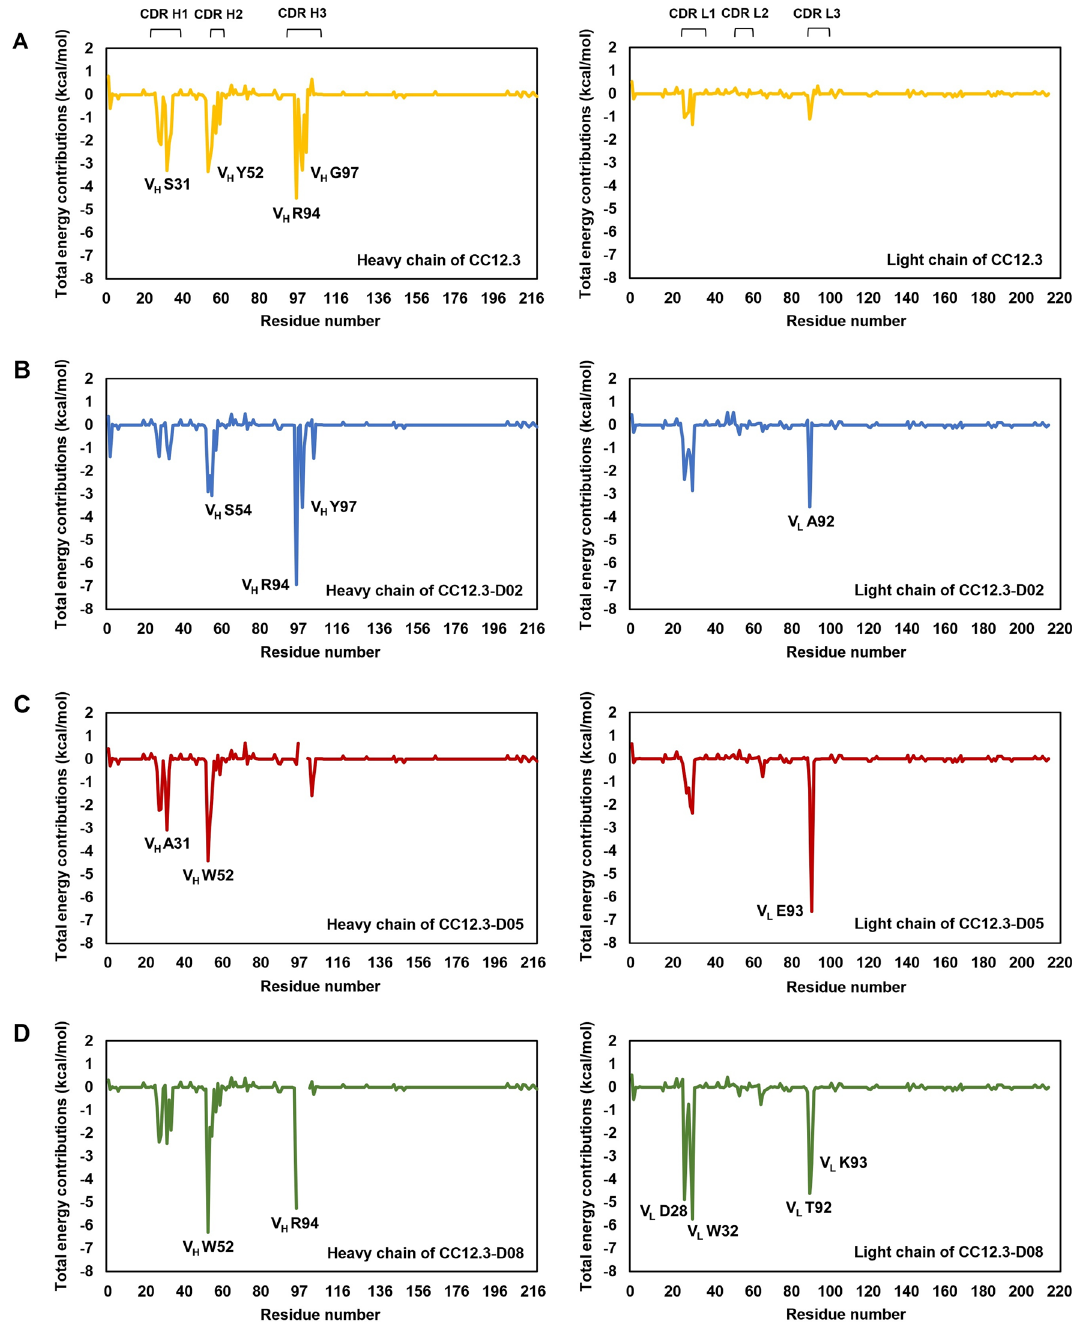
Figure 3. Per-residue free energy decomposition of ( A ) CC12.3, ( B ) CC12.3-D02, ( C ) CC12.3-D05, and ( D ) CC12.3-D08 in binding to SARS-CoV-2-RBD. The left and right panels show per-residue free energy decomposition of residues in CDR H1, H2 and H3, and CDR L1, L2 and L3, respectively. Residues with high binding affinities that have the total energy contribution better than − 3 kcal/mol are